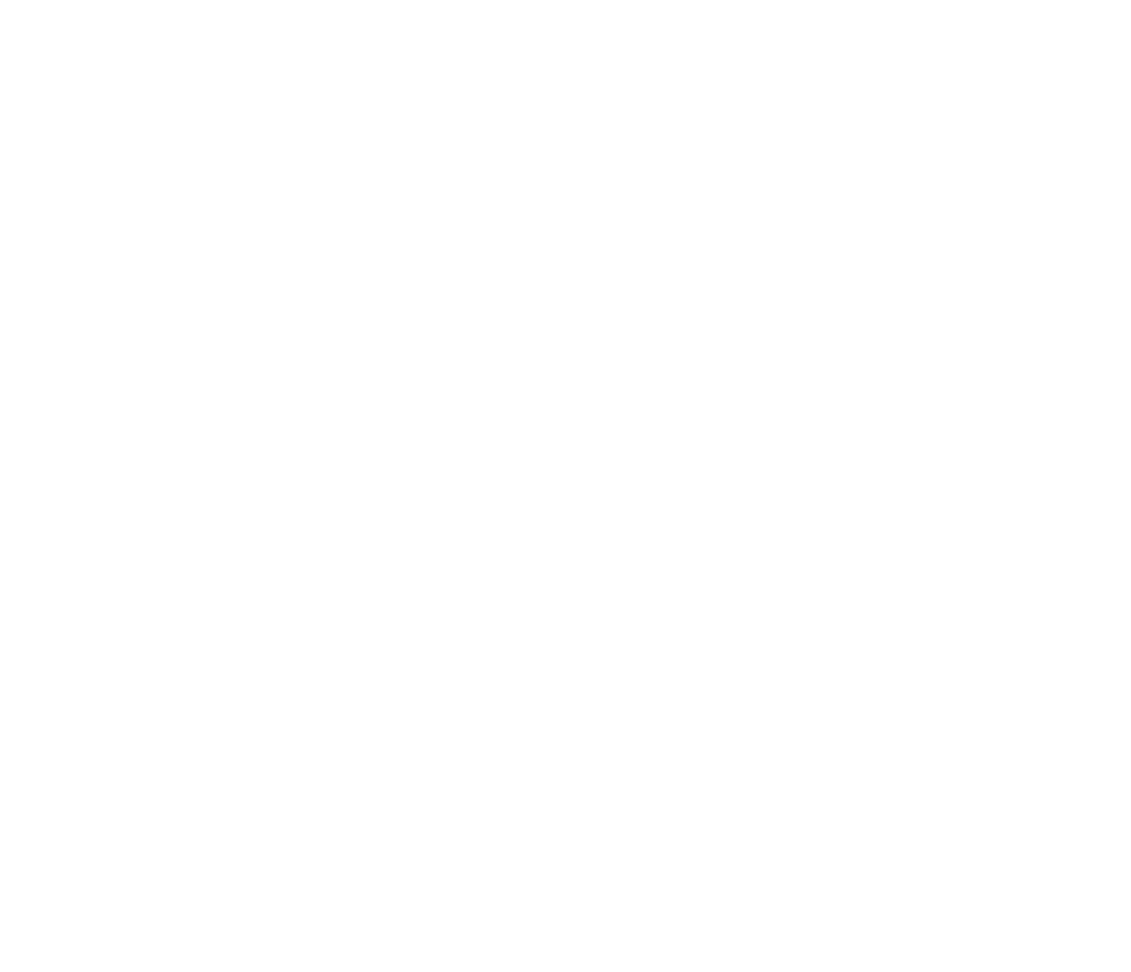
Frontiers in Sports and Active Living |